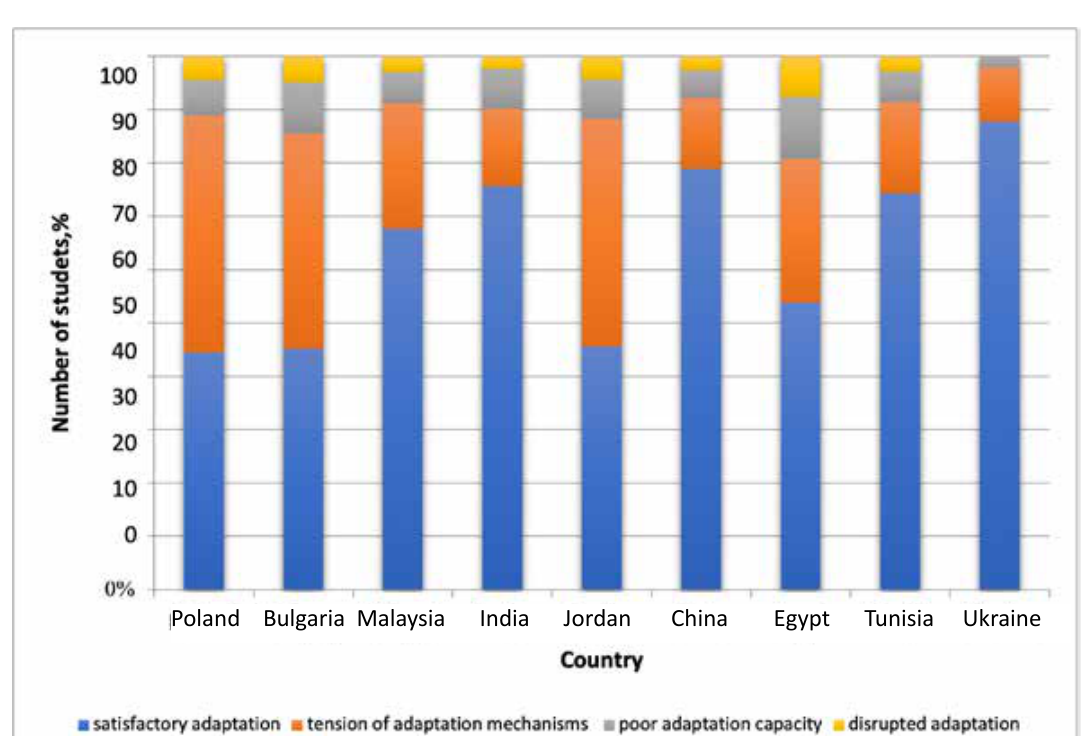
Figure 6. Distribution of students according to Baevsky adaptive capacity